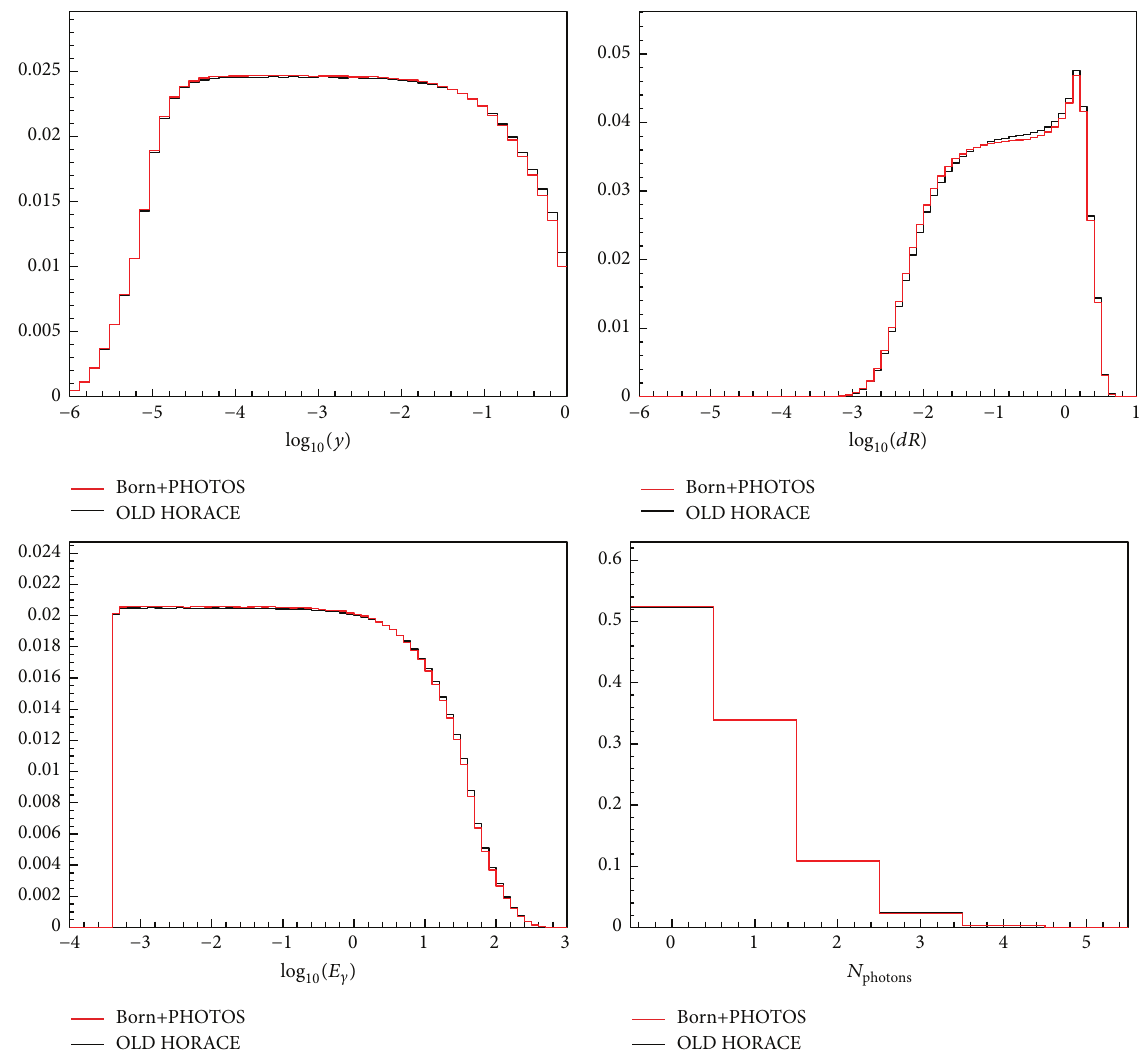
Figure 4: Clockwise from top-left: comparisons of the distributions of log 10 (𝑦 𝛾 ) , log 10 (Δ𝑅(𝑙𝛾)) , 𝑛 𝛾 , and log 10 (𝐸 𝛾 / GeV) for the 𝛾 ∗ /𝑍 → 𝜇 + 𝜇 − + 𝑛𝛾 process between the “Born” mode of old horace interfaced with photos and old horace in the exponentiation mode. The smaller of the two Δ𝑅 values with respect to the two muons is